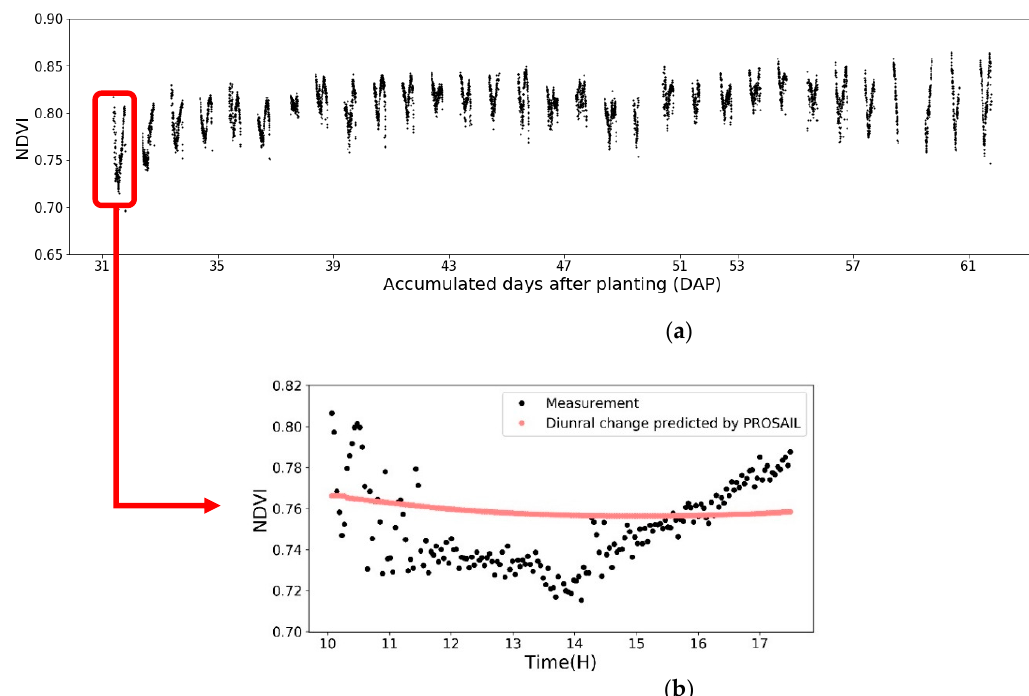
Figure 5. ( a ) The NDVI of HN and Genotype B73 × Mo17 plot from V4 stage to the R1 stage (Obtained from the hyperspectral images); ( b ) The NDVI measurements across Day 1 (black dots). The red curve is the predicted NDVI diurnal variance by PROSAIL model. Parameters for the PROSAIL model for the corn canopies followed the work of Ishihara et al. in 2015.